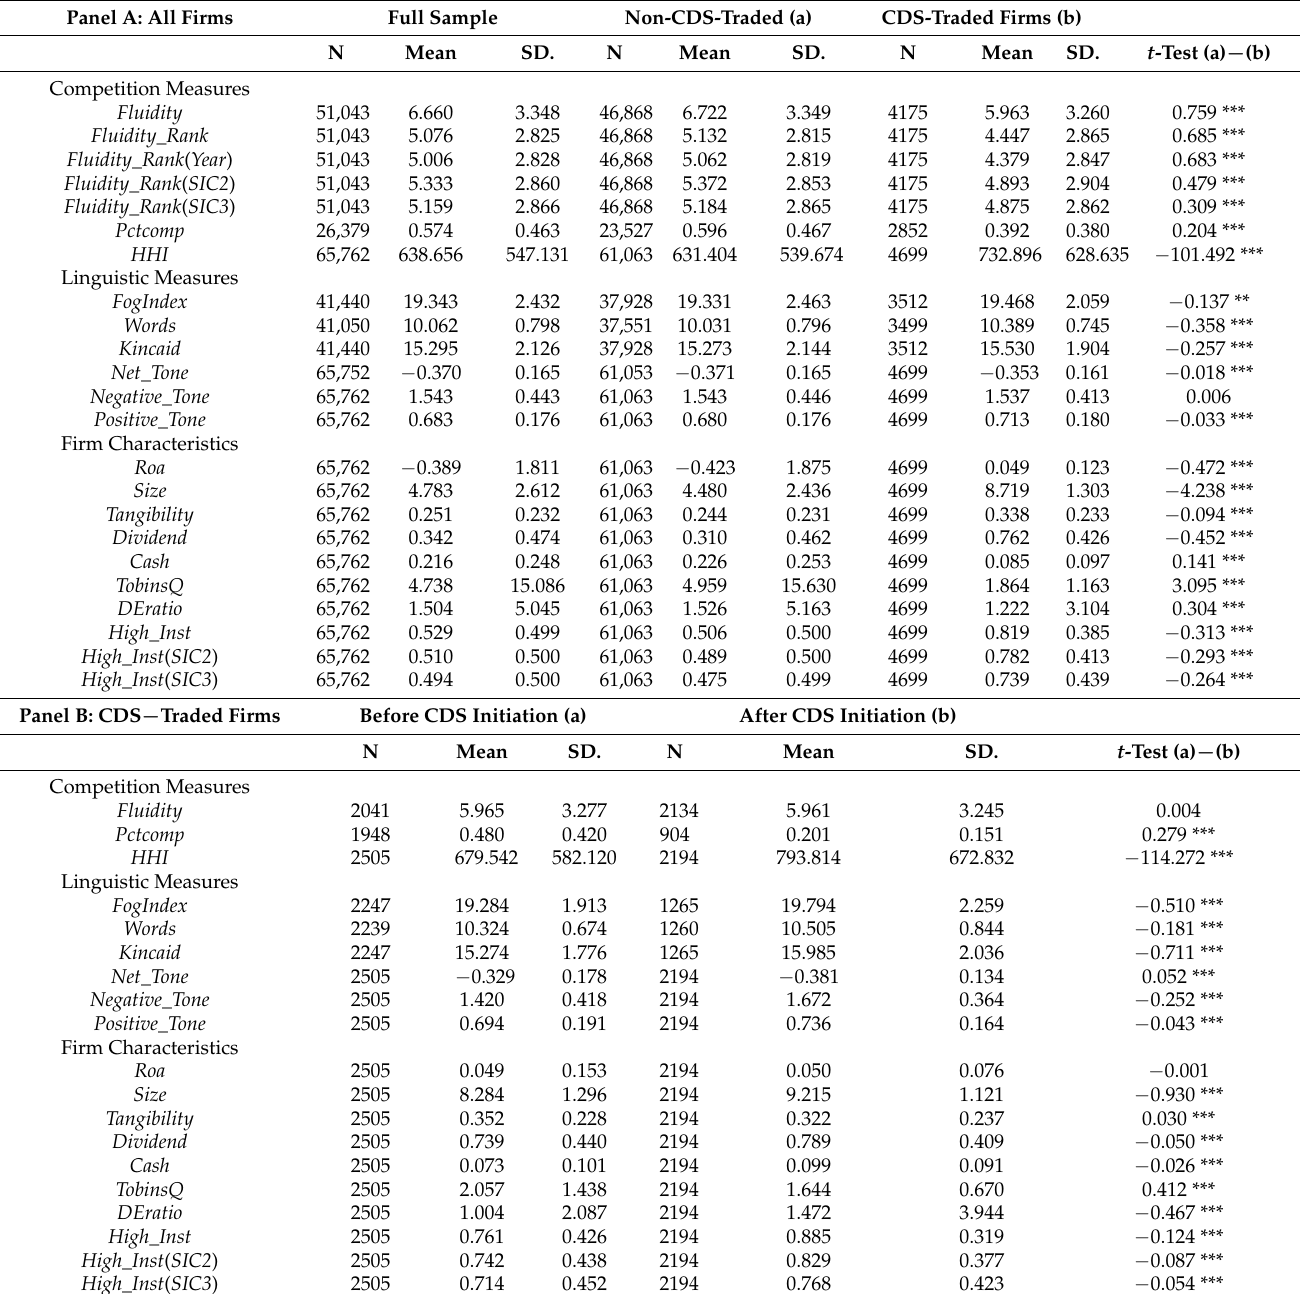
Table 1. Descriptive statistics. This table reports the descriptive statistics of our entire sample from 1994 to 2013. Panel A compares the statistics of non-CDS- and CDS-traded firms, whereas panel B compares the statistics of CDS-traded firms in the pre- and post-CDS initiation periods. The differences in means from the t -test are marked with ** or *** indicating a significance level of 0.05 or 0.01, respectively. For detailed definitions of variables, please refer to Appendix A Table